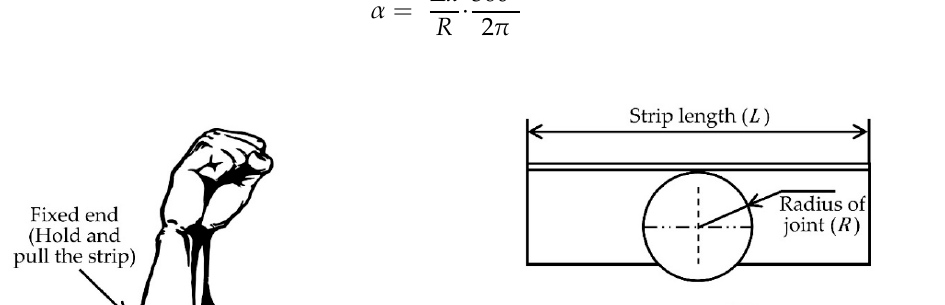
Figure 8. Block diagram of imaging-based human skeletal tracking.